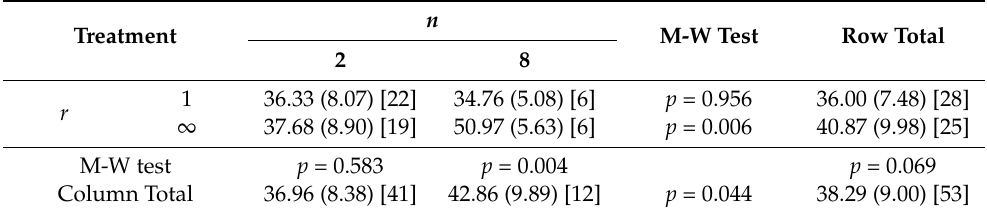
Table 2. Average bets by